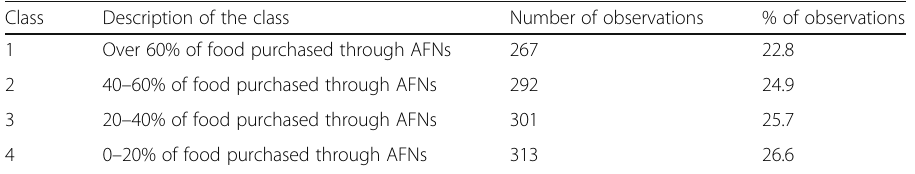
Table 2 Observations by class of expenditure at alternative